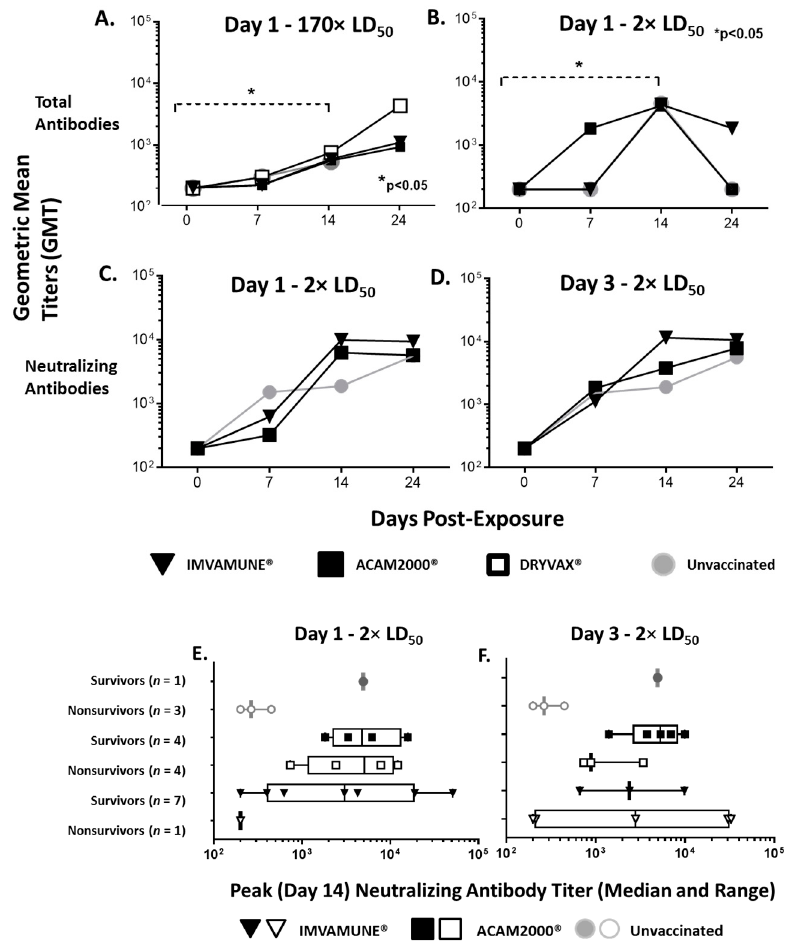
Figure 5. Humoral immune response. Total antibodies (geometric mean titers) at each time-point for animals challenged with 170 × LD 50 dose ( A ) or 2 × LD 50 dose ( B ) of monkeypox virus and unvaccinated (gray circles) or vaccinated 1 day postexposure with Dryvax ® (white squares), ACAM2000 ® (black squares), or IMVAMUNE ® (black triangles) showed significant increases from Day 0 to Day 14 by two-way ANOVA ( p < 0.05). A similar analysis of neutralizing antibody titers from animals challenged with 2 × LD 50 dose and vaccinated on Day 1 ( C ) or Day 3 ( D ) postexposure is keyed the same and showed no significant di ff erence between unvaccinated and vaccinated animals by two-way ANOVA. Geometric mean titers from peak neutralizing antibody response (Day 14) are shown for both surviving and nonsurviving animals challenged with 2 × LD 50 dose of monkeypox virus and vaccinated 1 ( E ) or 3 ( F ) days postexposure, with no significant di ff erences as measured by one-way